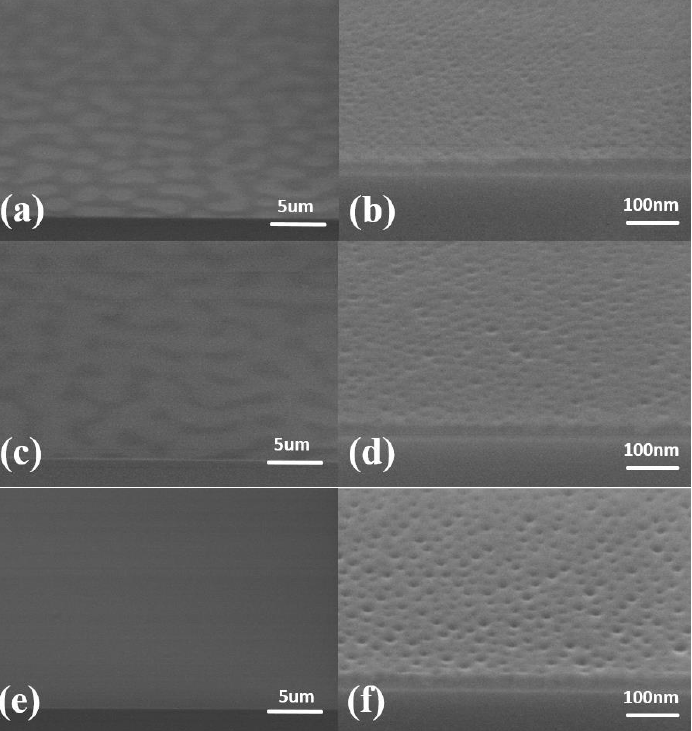
Figure 2. SEM images of vacuum atmosphere annealing. The thickness of blend materials is about 20 nm. The annealing temperature is 130 °C, and the annealing time is different: ( a , b ) 10 min; ( c , d ) 20 nm. The annealing temperature is 130 ◦ C, and the annealing time is different: ( a , b ) 10 min; 20 min; ( e , f ) 30 min. The vacuum degree is −0 .1 MPa. ( c , d ) 20 min; ( e , f ) 30 min. The vacuum degree is − 0.1